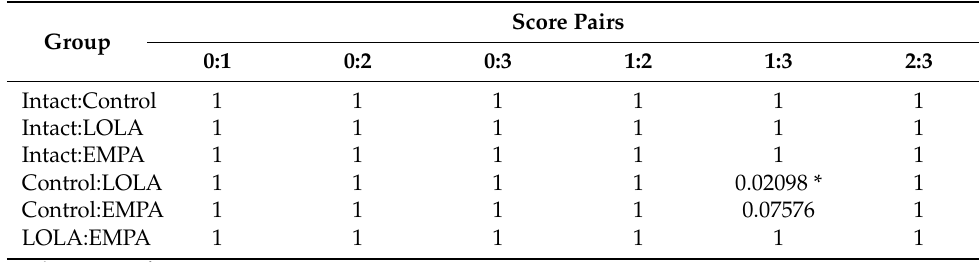
Table A1. Adjusted p -values for hepatitis score frequency distributions.